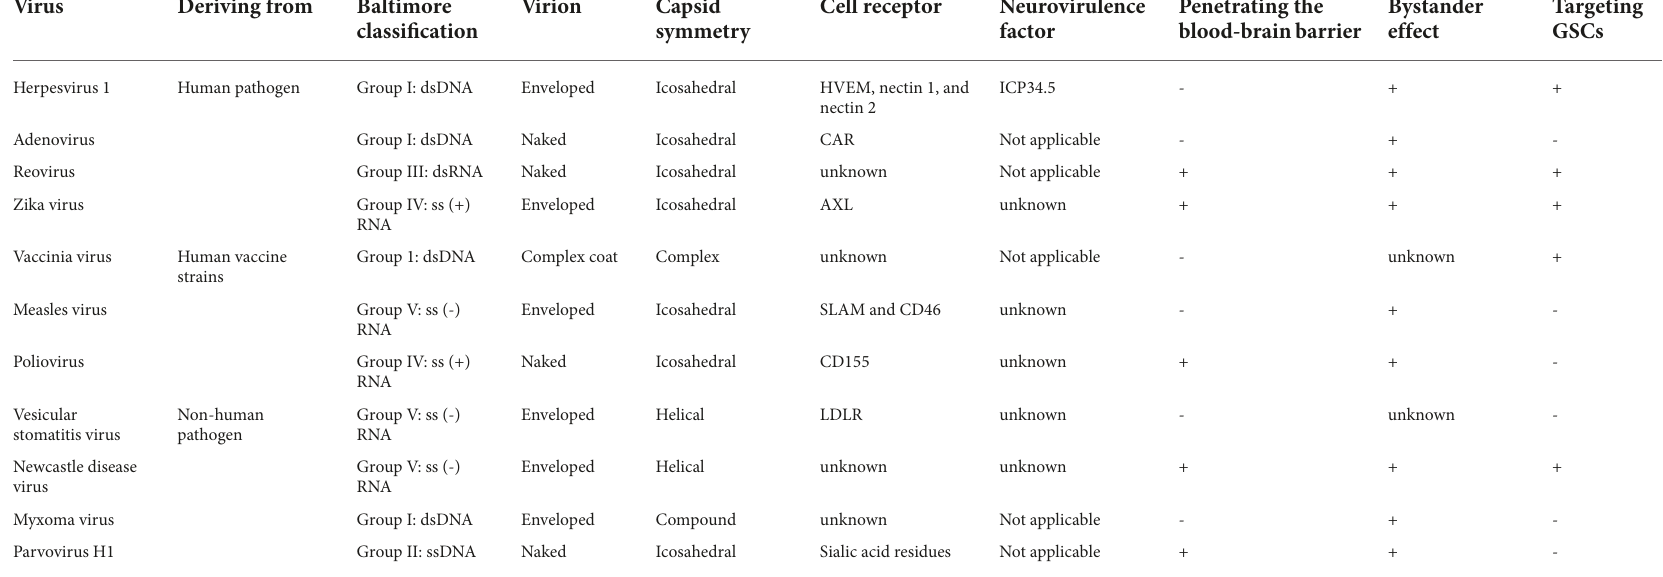
TABLE 1 Some details on oncolytic viruses used in GBM